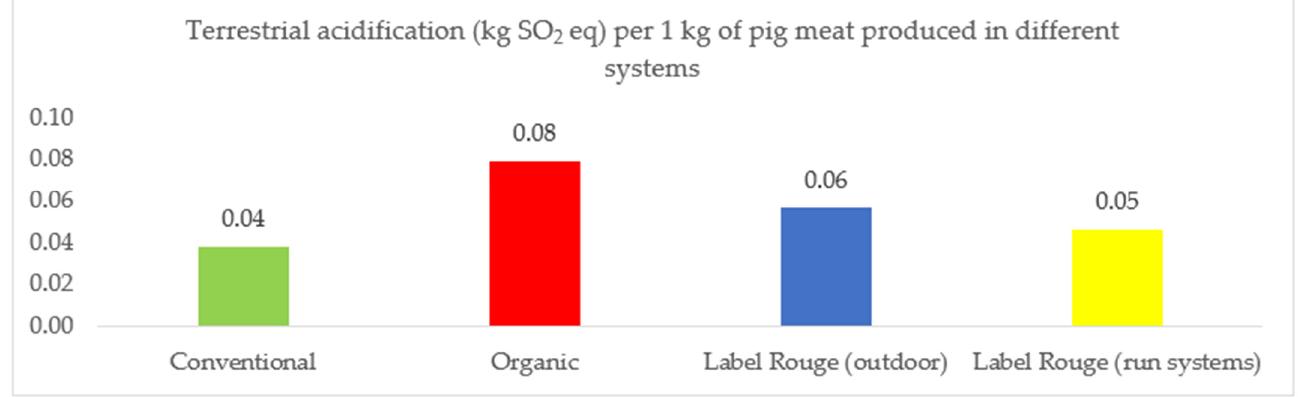
Figure 6. Terrestrial ecotoxicity per 1 kg Pig meat across organic, Label Rouge and Conventional systems: Data obtained from AGRIBALYSE ® database and computed using OpenLCA 1.10.2 [35,36].